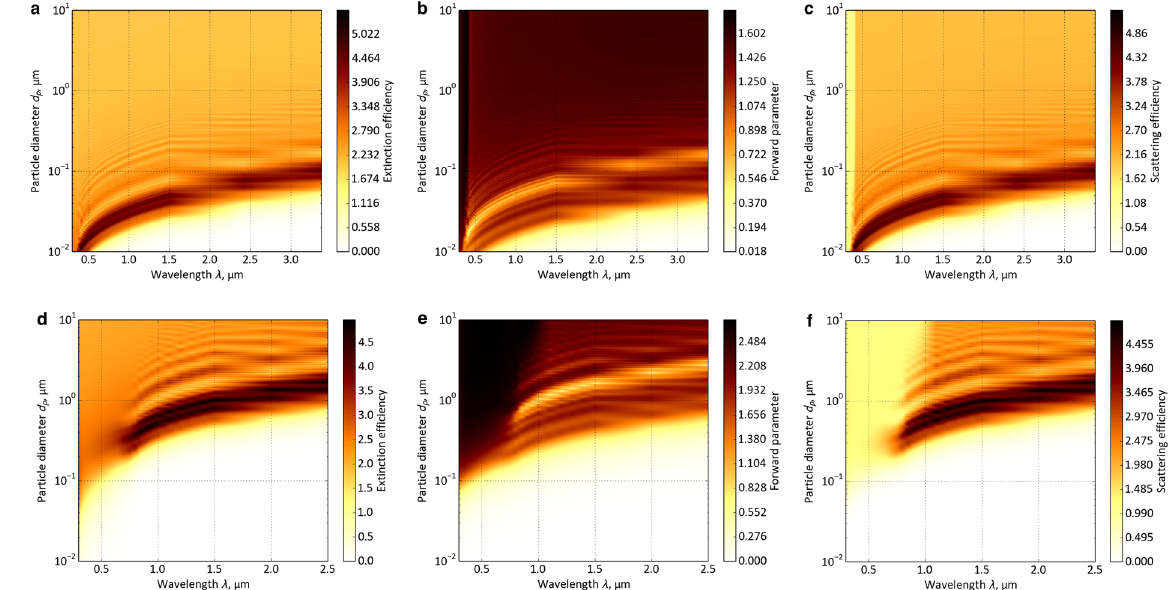
Figure 5. Spectral radiative properties of a single particle as a function of the particle diameter. ( a ) Spectral extinction efficiency of a TiO 2 particle. ( b ) Spectral forward parameter of a TiO 2 particle. ( c ) Spectral scattering efficiency of a TiO 2 particle. ( d ) Spectral extinction efficiency of a CuO particle. ( e ) Spectral forward parameter of a CuO particle. ( f ) Spectral scattering efficiency of a CuO